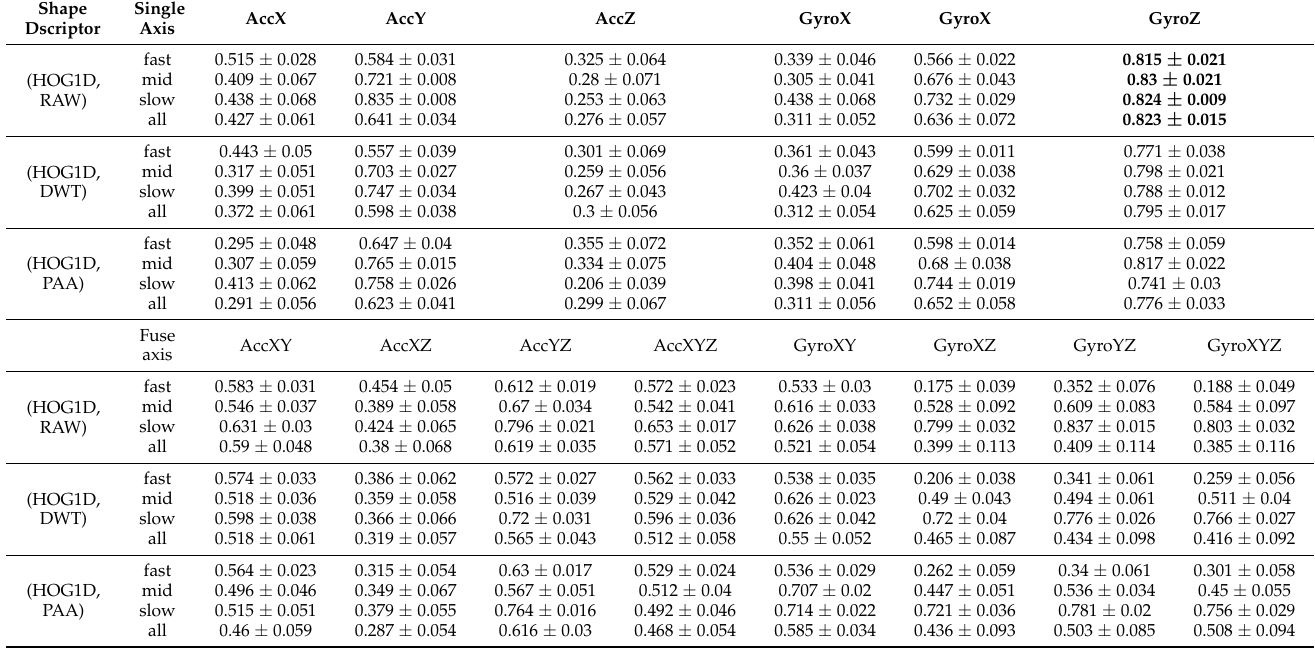
Table 6. Stride segmentation results of compound descriptor of different sensor axis combination schemes in F-measure values. Best results for each speed group are highlighted in bold numbers.